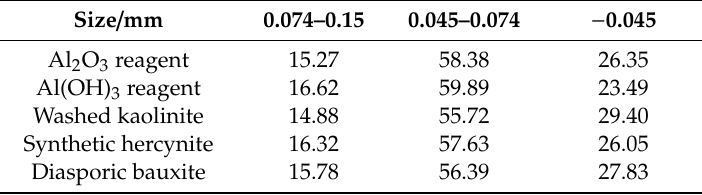
Table A2. Detailed data of size distributions of Al-additives.